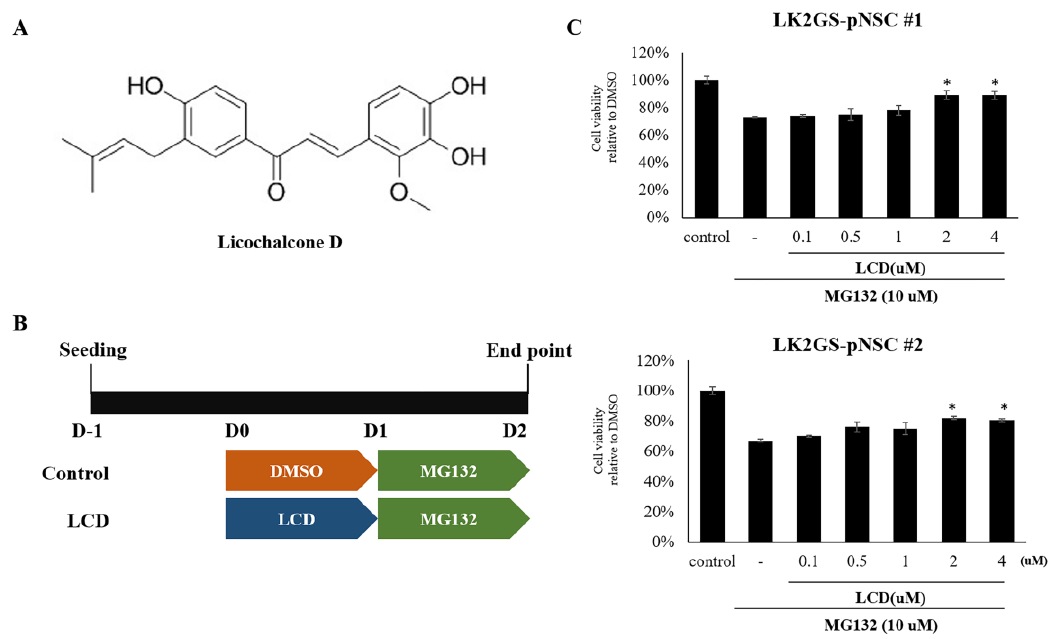
Figure 3. Cytoprotective effects of LCD on cellular stress in WT- and LK2GS-pNSCs. ( A ) Struc- ture of LCD. ( B ) Schematic diagram of treatment of LCD and MG132 in WT- and LK2GS-pNSCs. ( C ) Cytoprotective effects of LCD (0.1~4 µ M, 24 h) on WT- and LK2GS-pNSCs with the MG132 (10 µ M, 24 h)-induced oxidative stress condition. Data are mean ± S.E.M of at least three independent experiments. p -values were analyzed using the unpaired two-tailed Student’s t -test (* p <